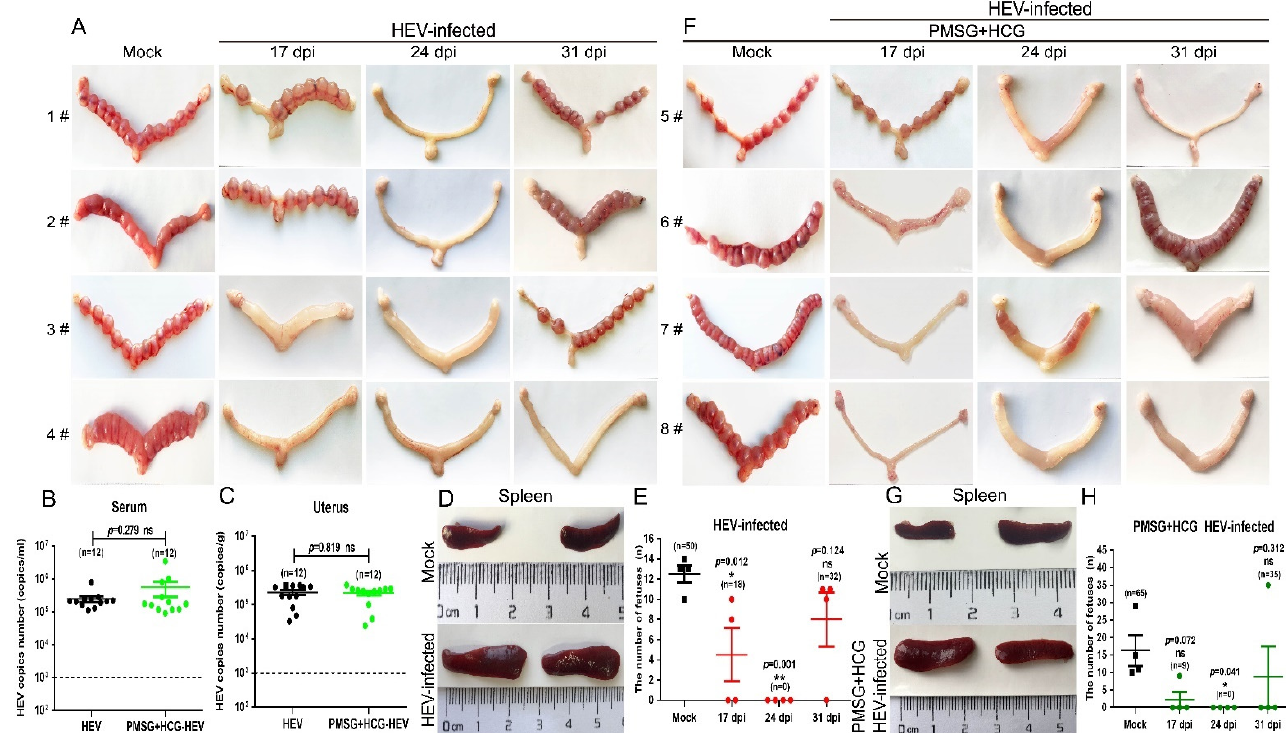
Figure 3. HEV infection results in decreased fertility in BALB/c female mice. ( A ) Morphological analysis of the uteruses from mock or HEV ‐ infected mice at 17, 24, and 31 dpi (E 10). The copy numbers of HEV RNA in the serum ( B ) and uterus ( C ) of HEV ‐ infected mice pretreated with or without PMSG and HCG were compared and analyzed by IBM SPSS Statistics 21 software. * p < 0.05; ** p < 0.01. ( D ) Sizes of spleens from mock or HEV ‐ infected mothers. ( E ) Number of fetuses born to mock or HEV ‐ infected mothers. ( F ) Morphological analysis of the uteruses from mock or HEV ‐ infected mice synchronized with PMSG and HCG at 17, 24, and 31 dpi (E 10). ( G ) Sizes of spleens from mock or HEV ‐ infected mothers who were synchronized with PMSG and HCG. ( H ) Number of fetuses born to mock or HEV ‐ infected mothers who were synchro ‐ nized with PMSG and HCG at 17, 24, and 31 dpi. Data were analyzed by IBM SPSS Statistics 21 software. * p < 0.05; ** p < 0.01.